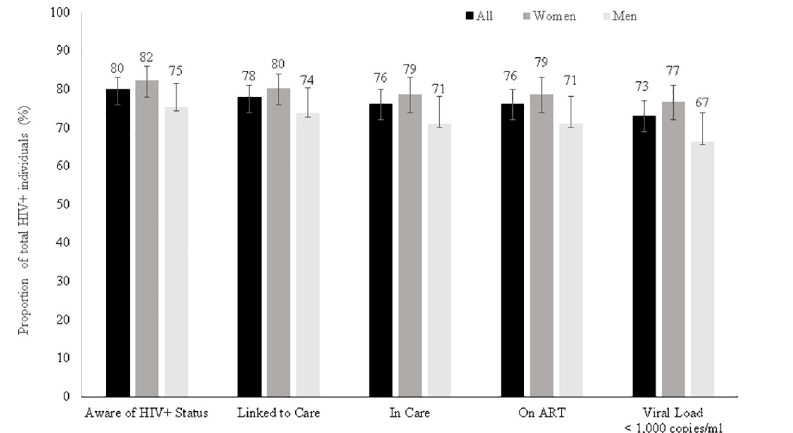
Fig 3. HIV cascade of care, Nsanje District, Malawi,